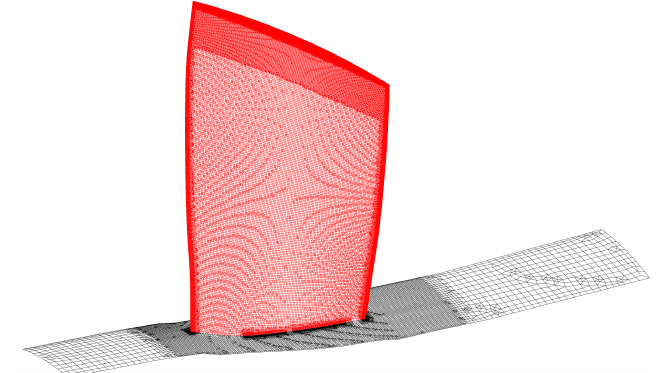
Figure 2. Overview of the detached-eddy simulation (DES) Computational